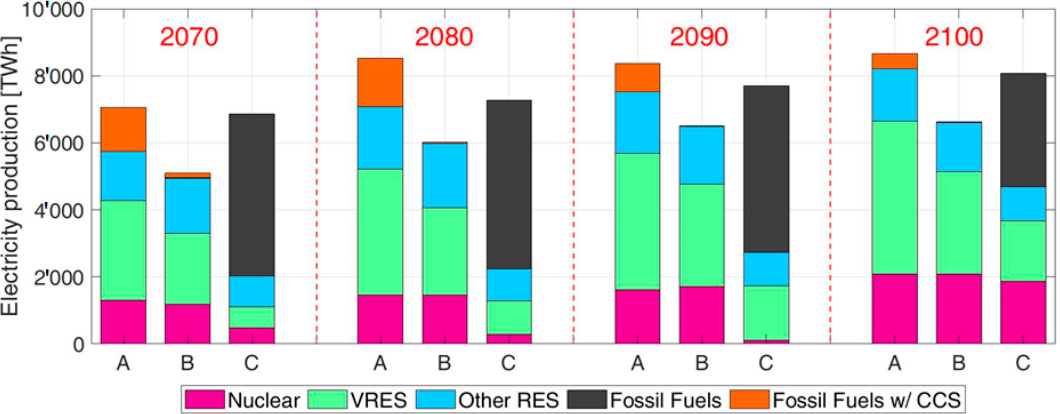
Figure 11. Evolution of the production mix for road transport electricity at selected time steps, for the different storylines.